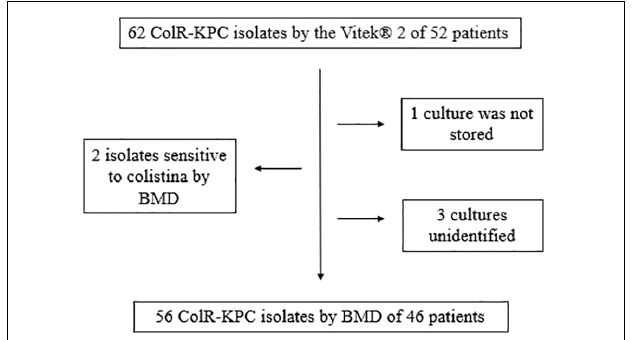
FIGURE 1 | Flowchart of ColR-CRKP positive culture cases identified during the study